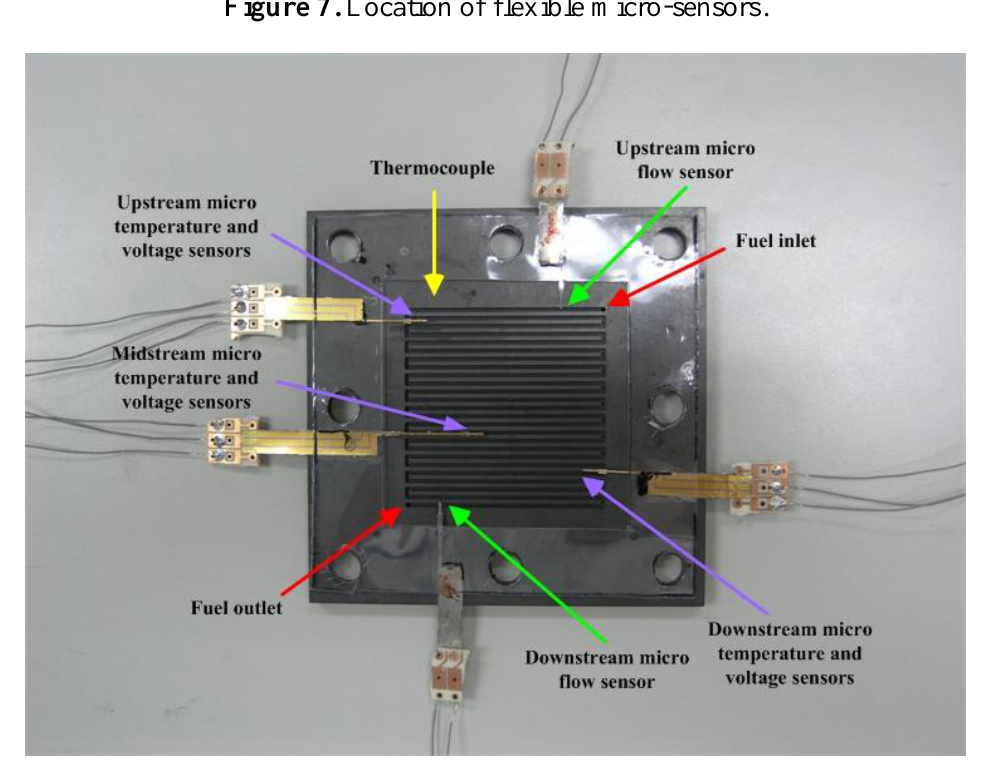
Figure 7. Location of flexible